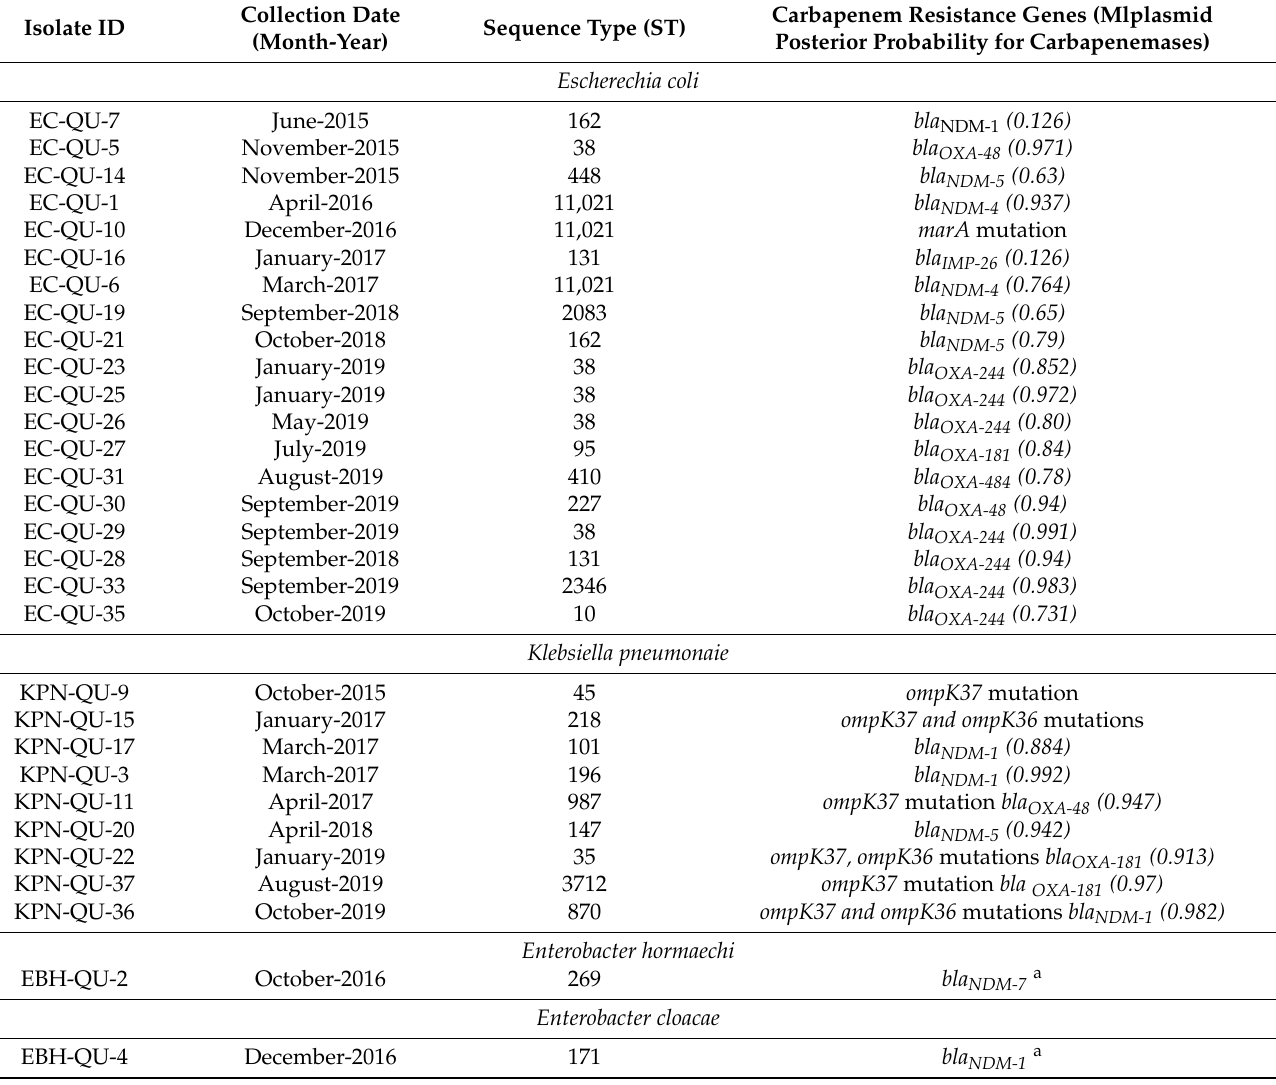
Table 2. Antibiotic resistance genes present in the isolates.